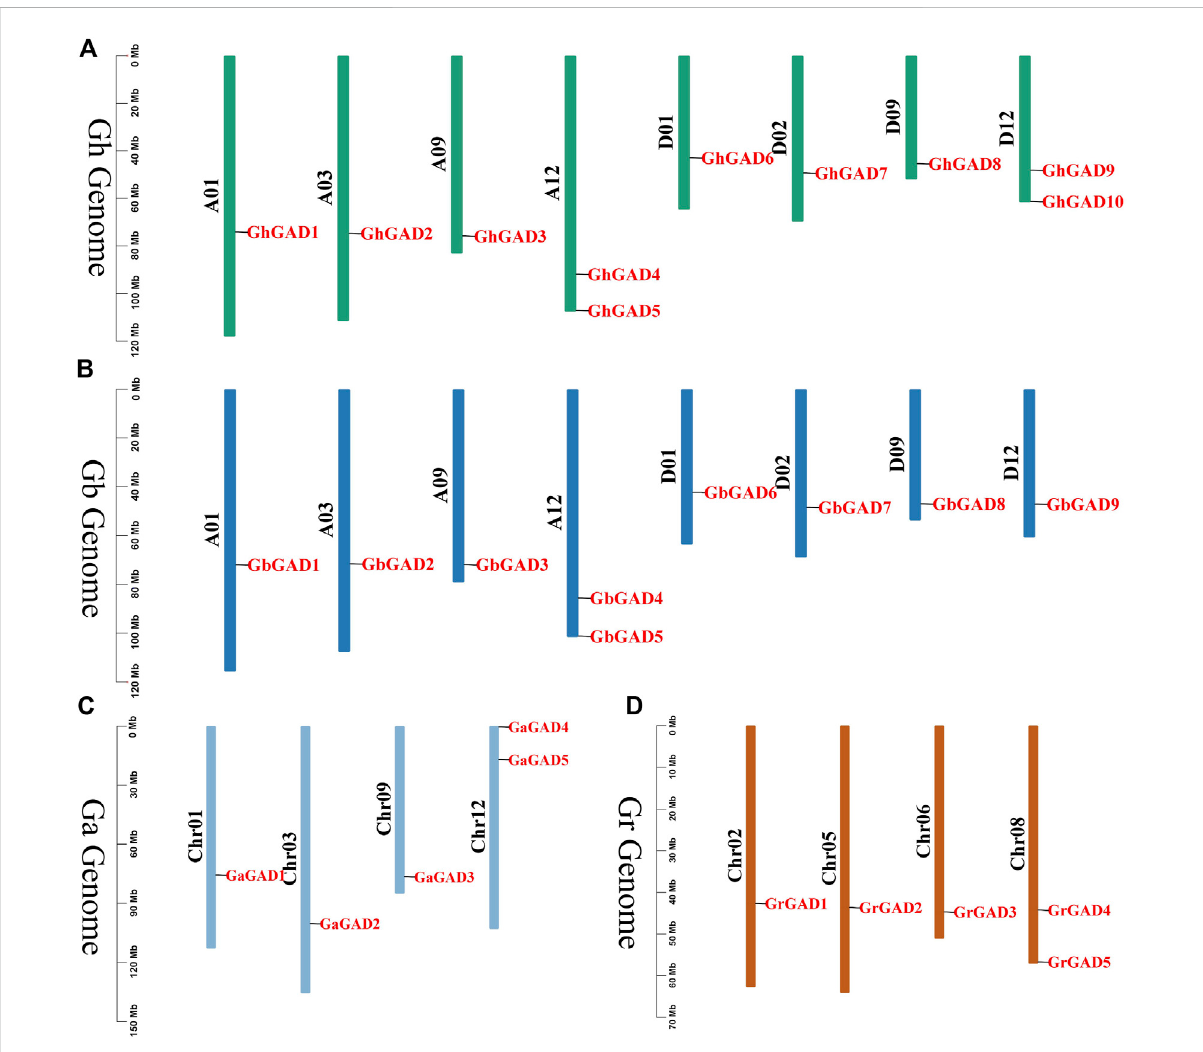
FIGURE 2 Chromosome distribution of GAD gene family in four Gossypium . (A) Chromosomal location of GADs on chromosomes in G. hirsutum . (B) Chromosomal location of GADs on chromosomes in G. arboreum . (C) Chromosomal location of GADs on chromosomes in G. barbadense . (D) Chromosomal location of GADs on chromosomes in G. raimondii . The scale of the genome size was given on the